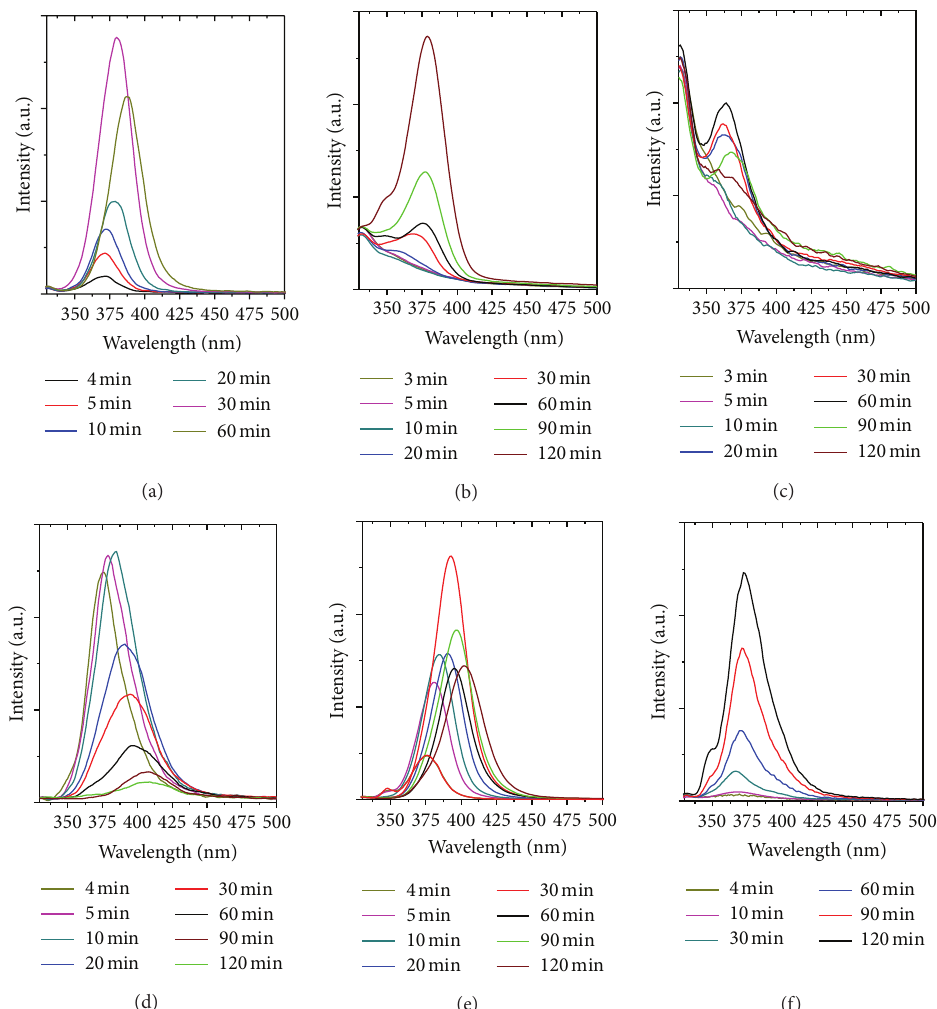
Figure 2: PL spectra of ZnSe NCs synthesized at 220 ∘ C using different Zn precursors: (a) 0.4mmol ZnAc 2 , (b) 0.4 mmol Zn(NA) 2 , (c) 0.4 mmol ZnSt 2 , (d) 0.6 mmol ZnAc 2 , (e) 0.6mmol Zn(NA) 2 , and (f) 0.6 mmol ZnSt 2